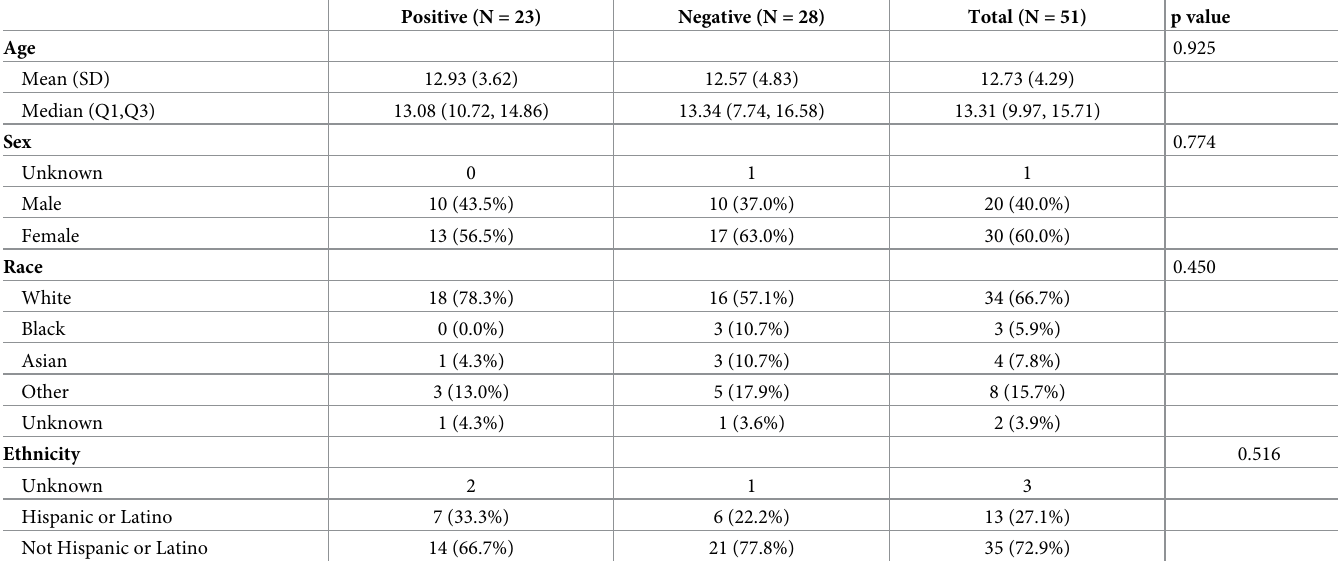
Table 1. Demographics of 51 children who underwent COVID-19 testing.